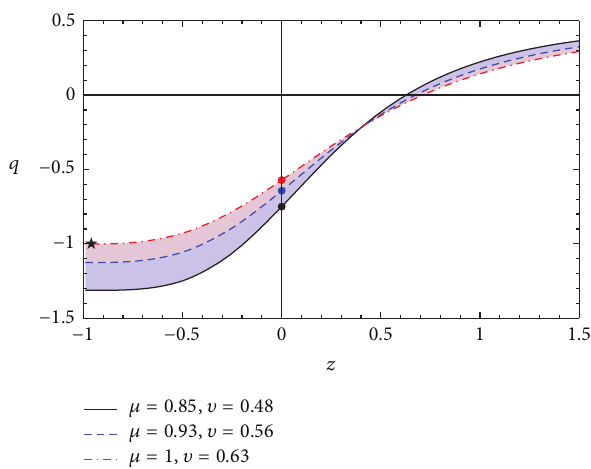
Figure 16: Evolution trajectories of 𝑞 in NHDE for different values of parameters (𝜇,𝜐) with −1 ≲ 𝑧 ⩽ 2 . The dot denotes the present day, and star represents the Λ CDM model.